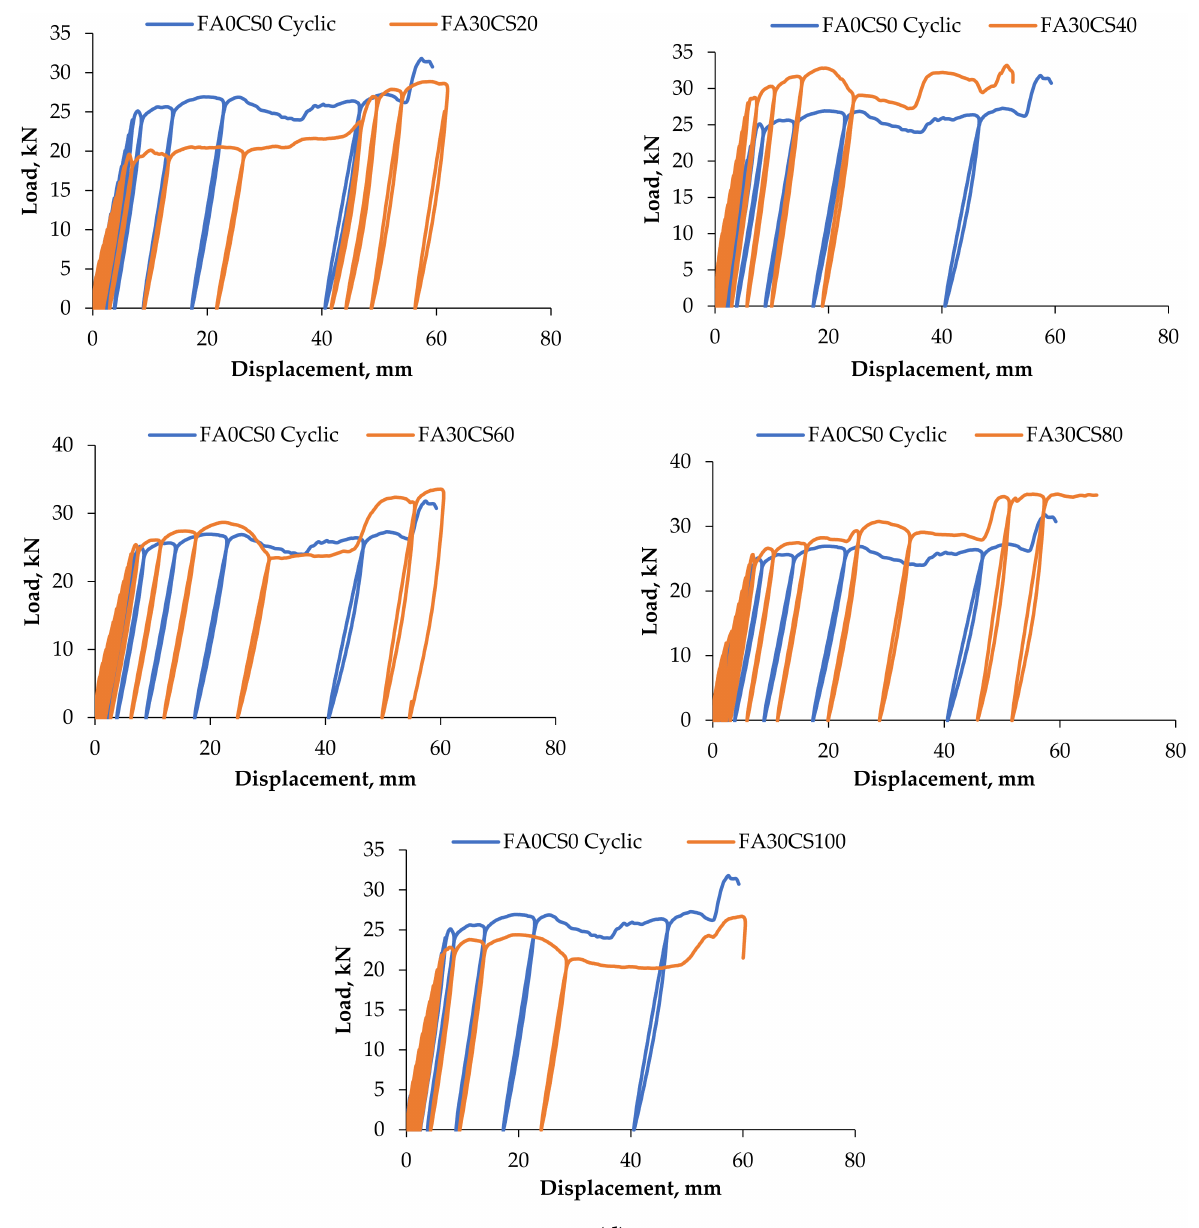
Figure 8. Load and deflection curves: ( a ) Batch I: The addition of 0% FA and 20–100 CS, ( b ) Batch II: the addition of 10% FA and 20-100 CS, ( c ) Batch III: the addition of 30% FA and 20-100 CS, ( d ) Batch IV: the addition of 3% FA and 20-100